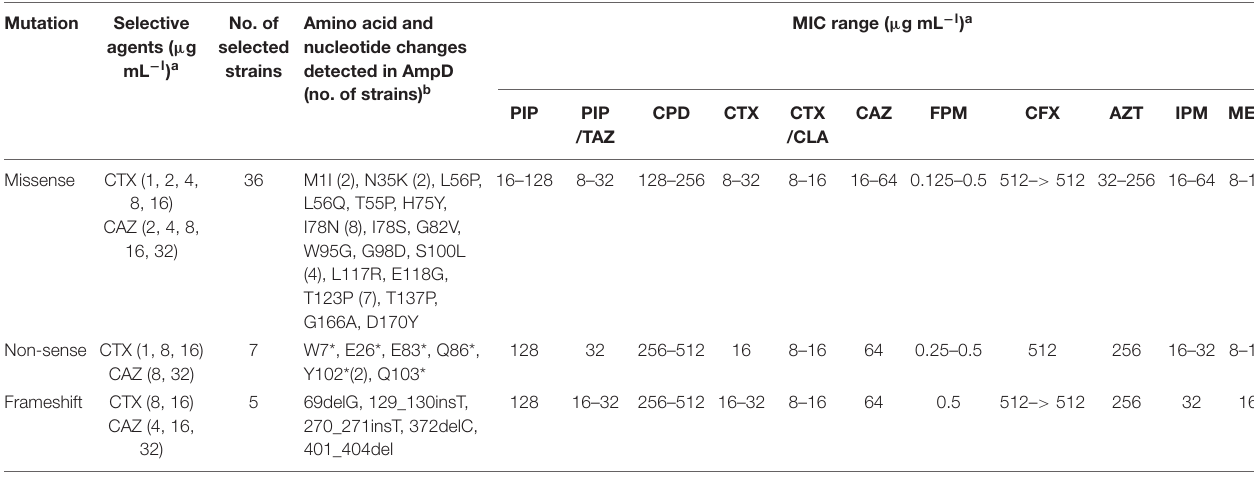
Non-sense CTX (1, 8, 16) CAZ (8,